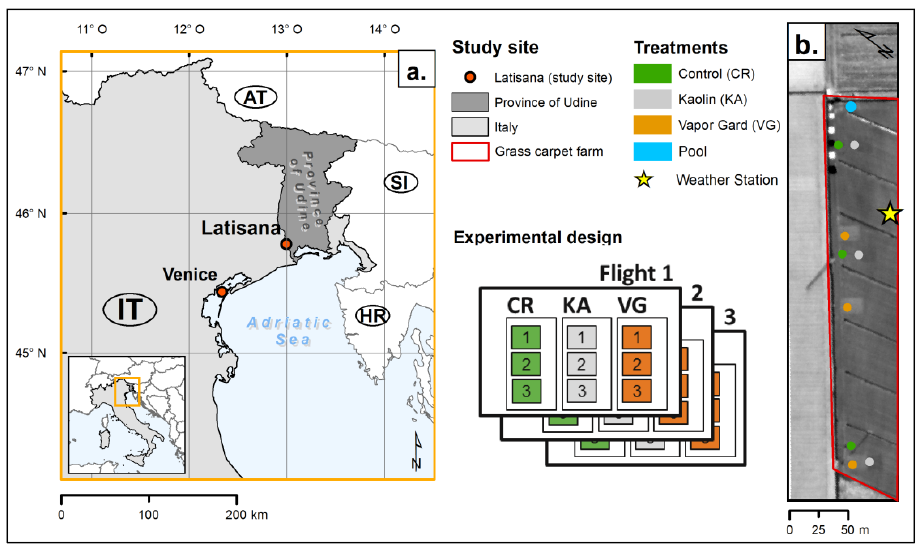
Figure 1. Overview of the study site with the experimental setup. The study site was located in northeastern Italy near the town of Latisana ( a ). ( b ) shows the locations of the experimental plots, pool and weather station. A scheme of the experimental design is presented in the legend.